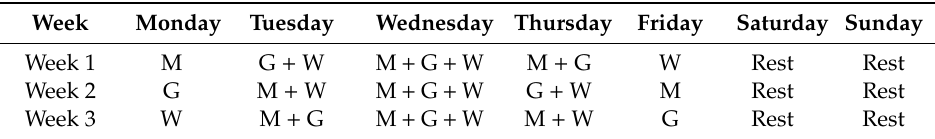
Table 1. Training sessions distribution per exercise